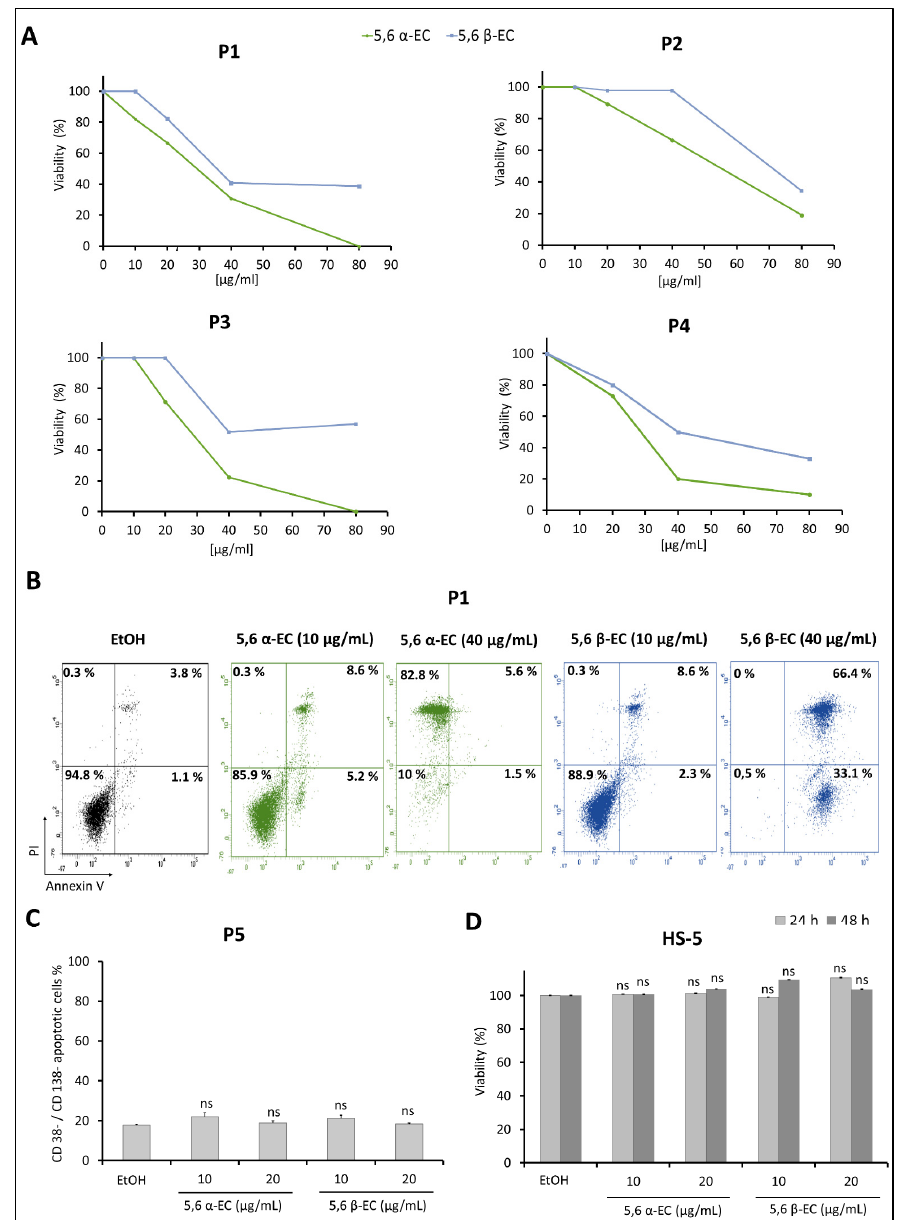
Figure 6. 5,6-ECs display selective cytotoxic and apoptotic activities on human primary malignant plasma cells. ( A ) Cytotoxic activity of compounds was assessed on patient malignant cells of P1, P2 and P3 by MTT and for P4 cells by Trypan blue. For this, mononuclear cells (BMNCs) were purified from bone marrow and cell sorting using CD138 microbeads was assessed for P1-P4. CD138+ malignant plasma cells were cultured for 40 h in the absence or presence of 10–80 µ g/mL of 5,6 α -EC or 5,6 β -EC. ( B ) Annexin V staining and flow sorting was used to detect the apoptotic population in sorted CD138+ cells of P1 after treatments with 10 or 40 µ g/mL 5,6 α -EC or 5,6 β -EC. Flow cytometry profiles for all cell compartments (annexin V–/PI–, annexin V+/PI–, annexin V+/PI+ and annexin V-/PI+) with